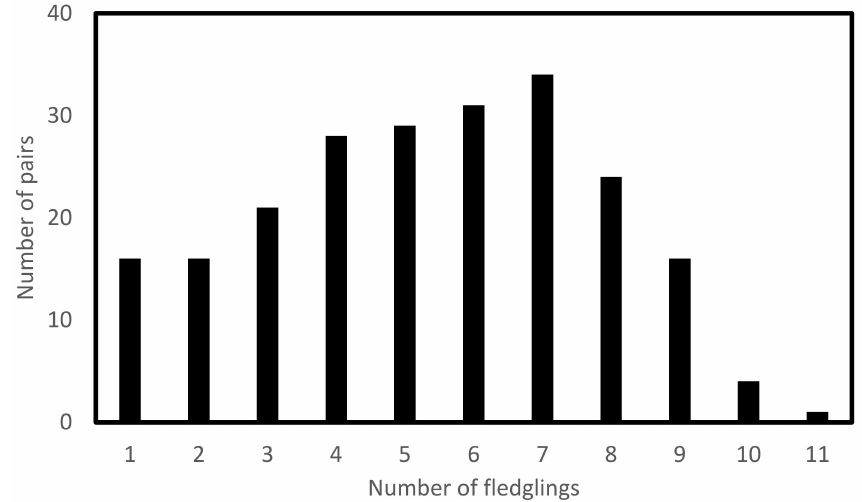
Figure 2. The number of nestlings that fledged per pair during the 2012–2019 breeding